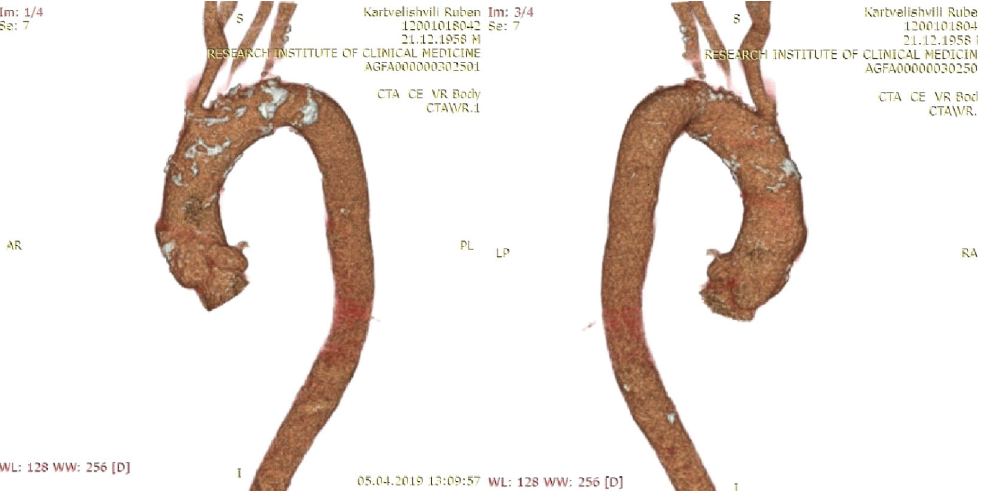
Figure 1: Computed tomography angiography.